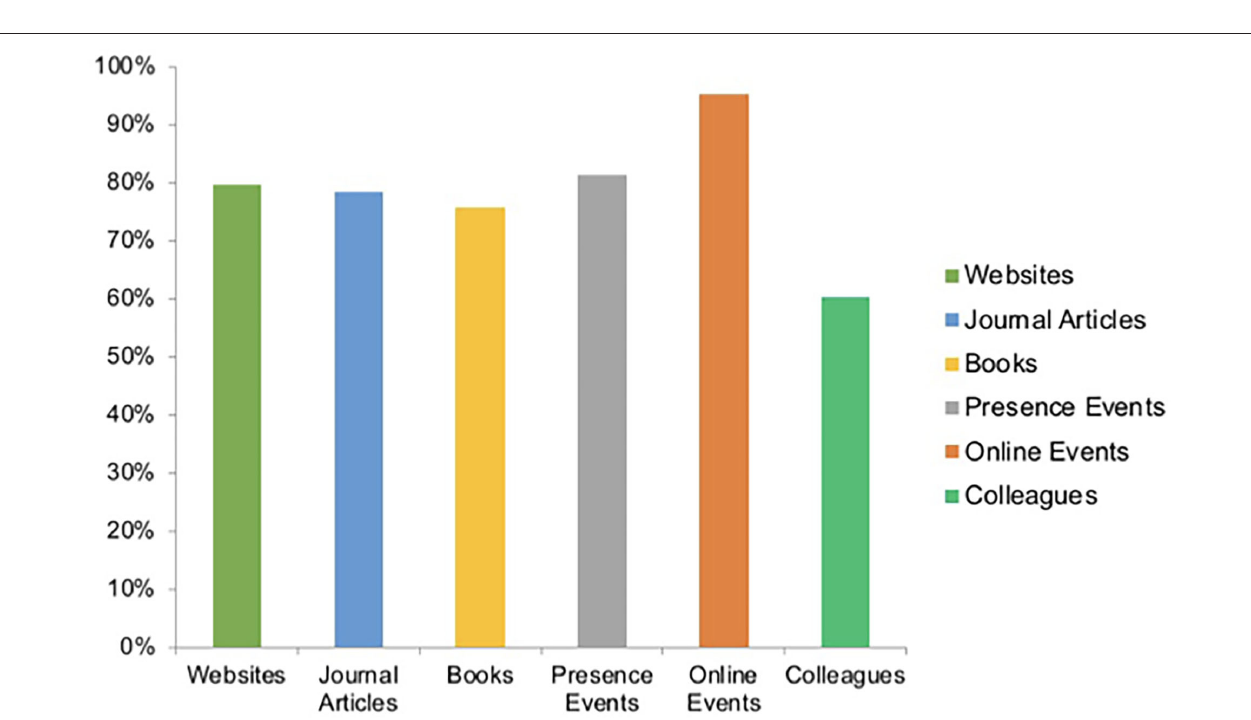
FIGURE 4 | Sources of continuing medical education (percentage). Most responses identified online and face-to-face events as the main source of continuing medical education. Percentages were calculated for a question with multiple answer options.